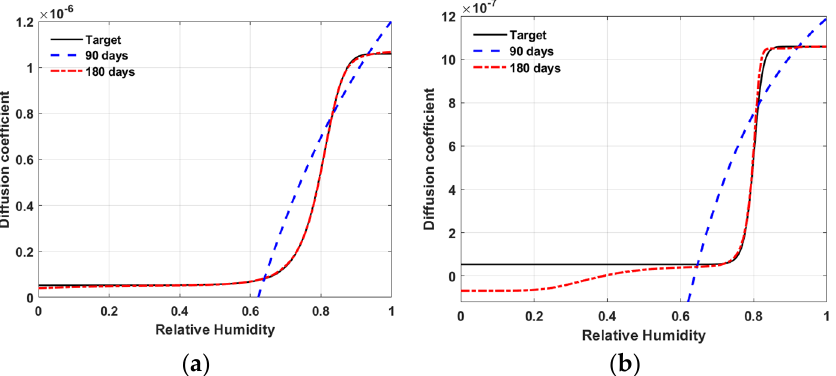
Figure 14. Results of inverse estimation using N2—target model versus ANN model ( a ) material M1; ( b ) material M2.